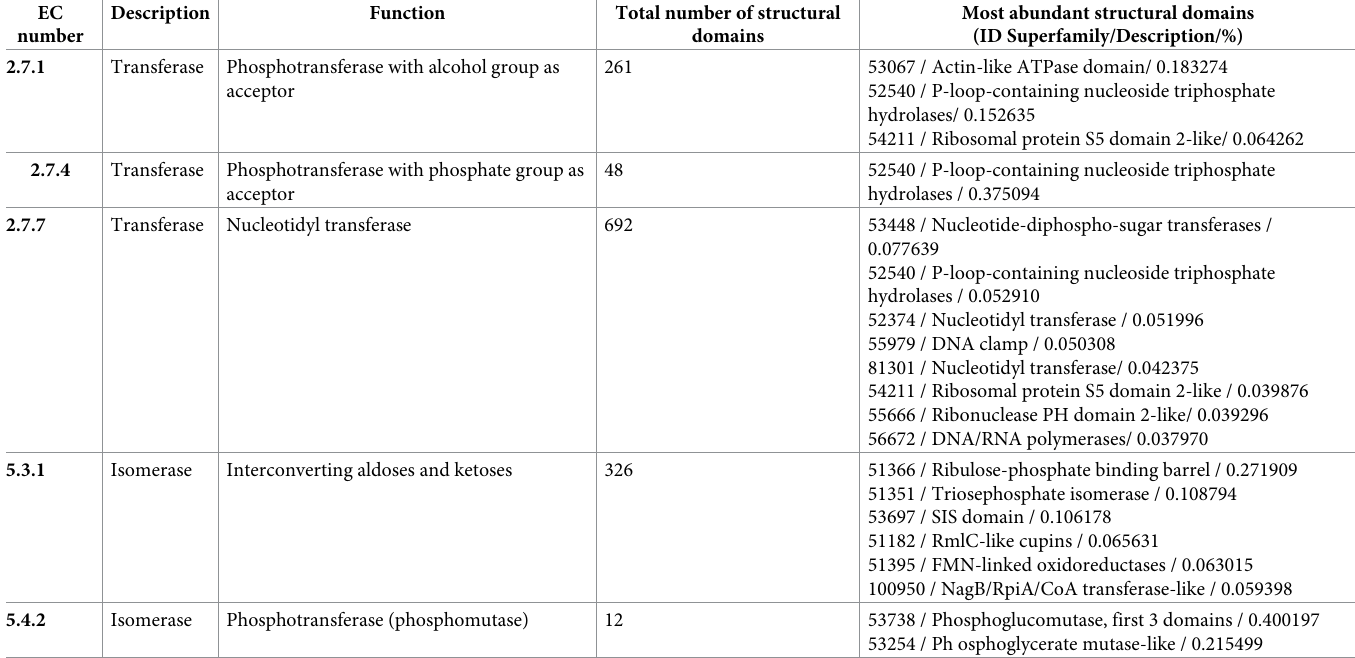
Table 1. Five EC numbers are universally distributed in Bacteria, Archaea and Eukarya. In the fourth column is indicated the frequency of each protein domain identi- fied by Superfamily